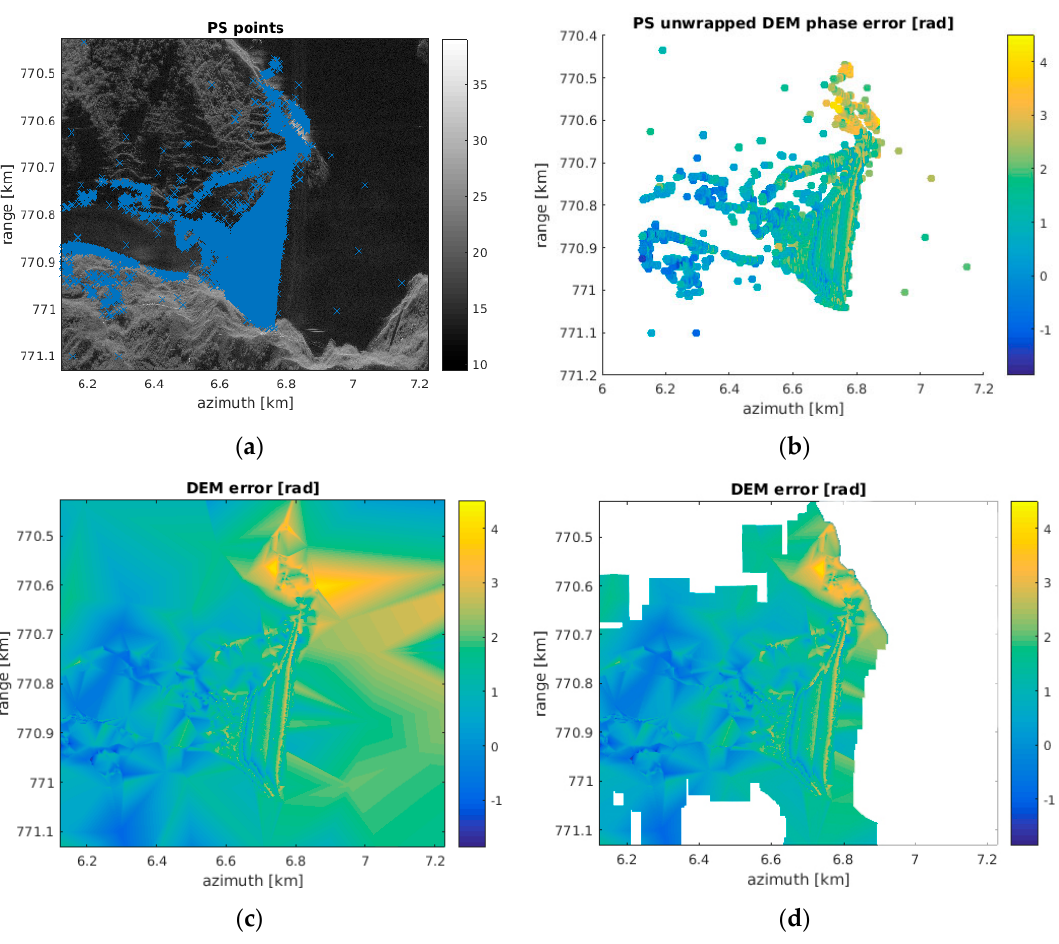
Figure 9. The DEM error maps in the dam area. ( a ) The PS points via PS − InSAR in the test area (03/06/2016). ( b ) The unwrapped phase of DEM error map at the PS points (03/06/2016), PS points over the surface of the water might be caused by range or azimuth ambiguities. ( c ) The unwrapped phase of the DEM error map via PS − InSAR (03/06/2016). ( d ) The unwrapped phase of the DEM error map via PS − InSAR (03/06/2016); the river and no PS point in the 100 m range are masked.